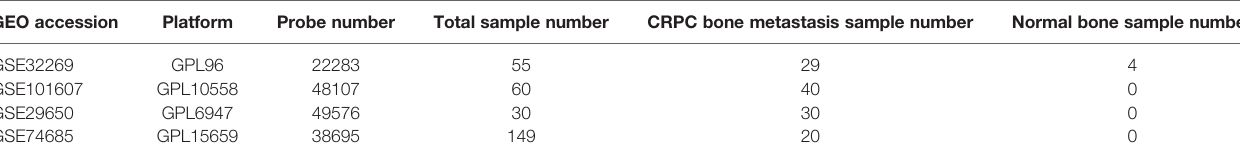
TABLE 1 | Datasets of gene expression pro fi les. GEO accession Platform Probe